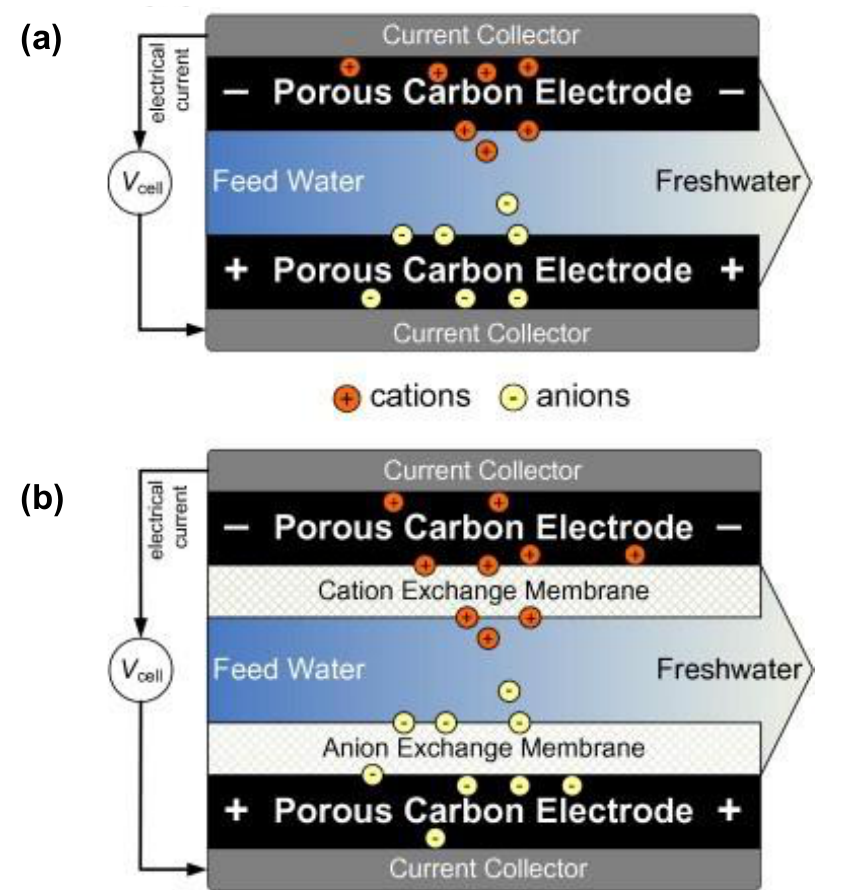
Figure 1. Comparison of ( a ) CDI cell and ( b ) membrane CDI cell with carbon electrodes. Reproduced with permission from [3]. Copyright 2013 Elsevier.